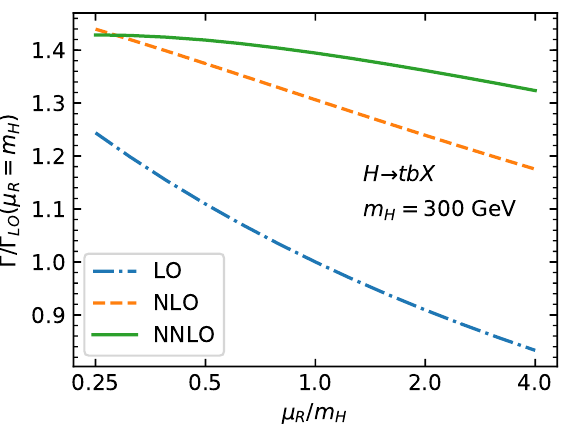
Figure 2. Renormalization scale dependence of the LO (dot-dashed blue line), NLO (dashed orange line) and NNLO (green line) partial decay width of a 300 GeV charged Higgs boson decaying into a top quark and jets. All results are normalized to the LO partial width at central scale µ R = m H . Monte-Carlo uncertainties are rather small and are not shown